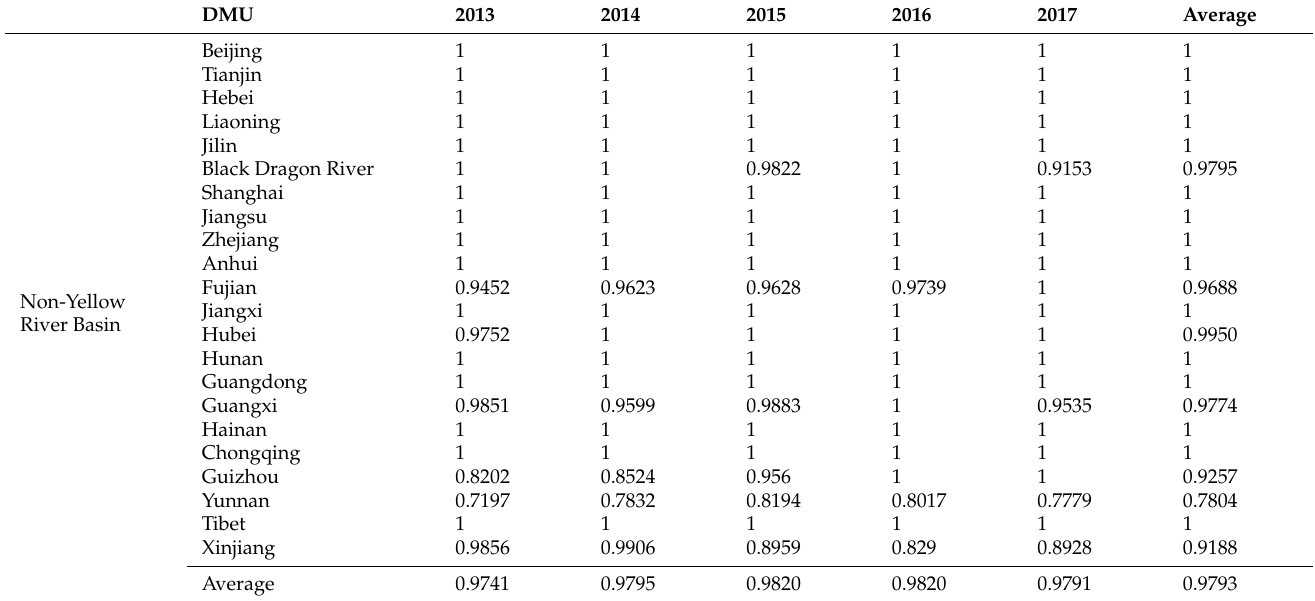
Table A1. Efficiency of DDF in the Yellow River and Non-Yellow River basins from 2013 to